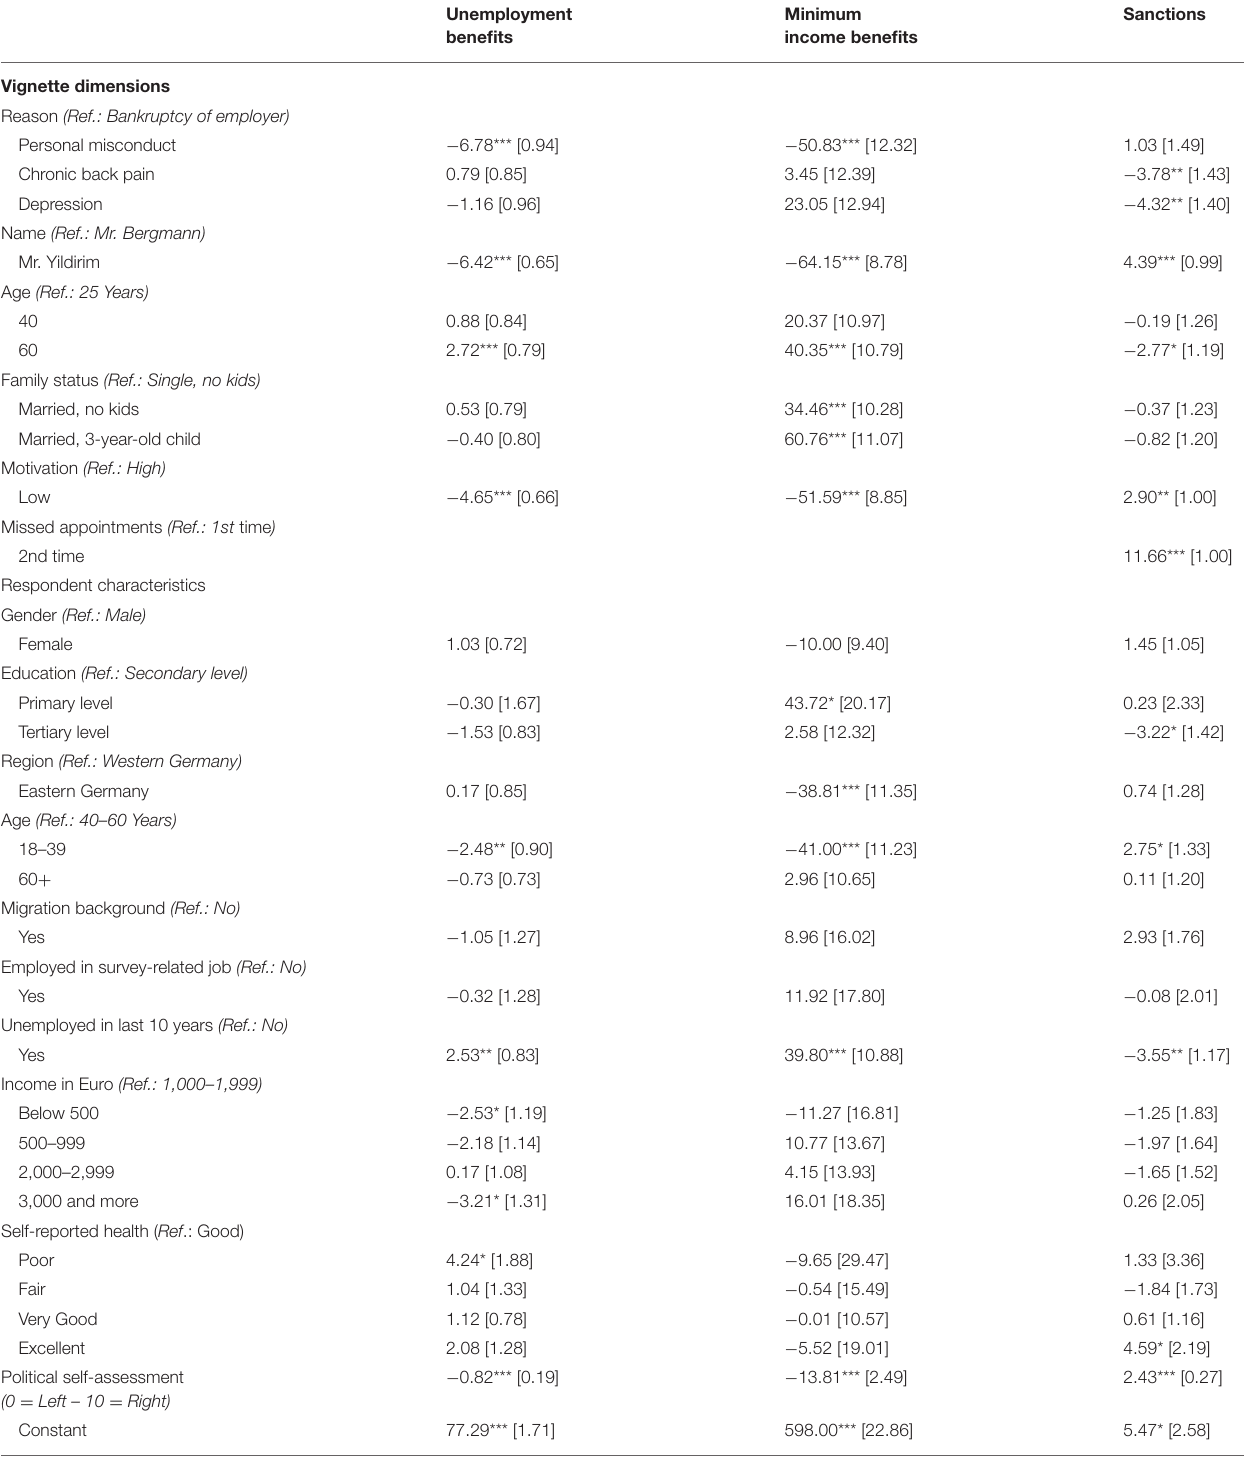
TABLE 3 | OLS regression of allocation of unemployment benefits, minimum income benefits and sanctions on vignette dimensions and respondent characteristics.